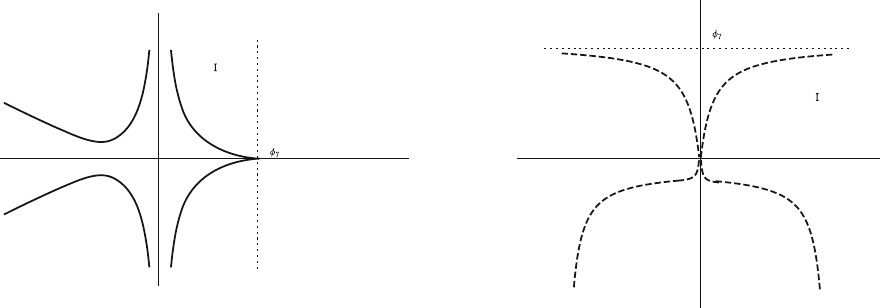
and two conjugate 7